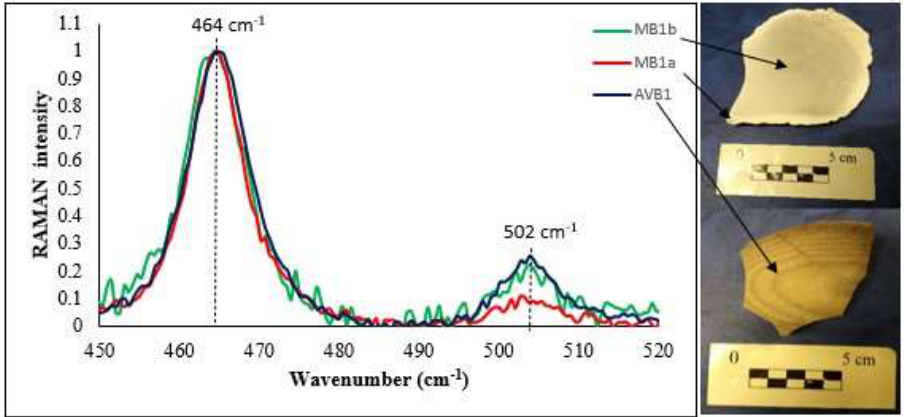
Figure 13. Raman spectra obtained by bulk samples. The labelled peaks at 464 cm −1 and 502cm −1 are the bands of quartz and moganite. The picture on the right shows samples MB1 (top) and AVB1 (bottom), and the arrows display the areas where the spectra were obtained.